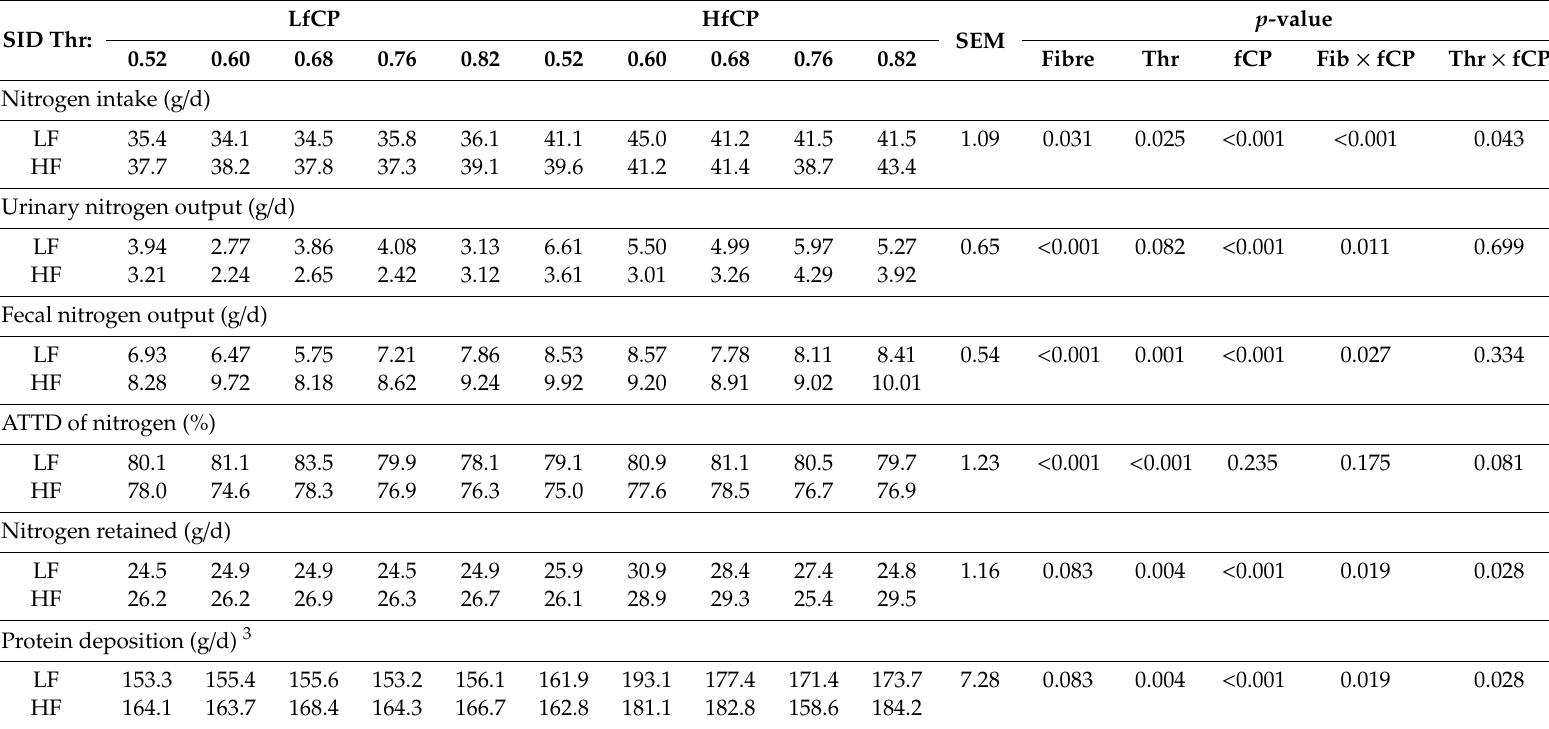
Table 2. Dietary treatment e ff ects on protein deposition 1,2